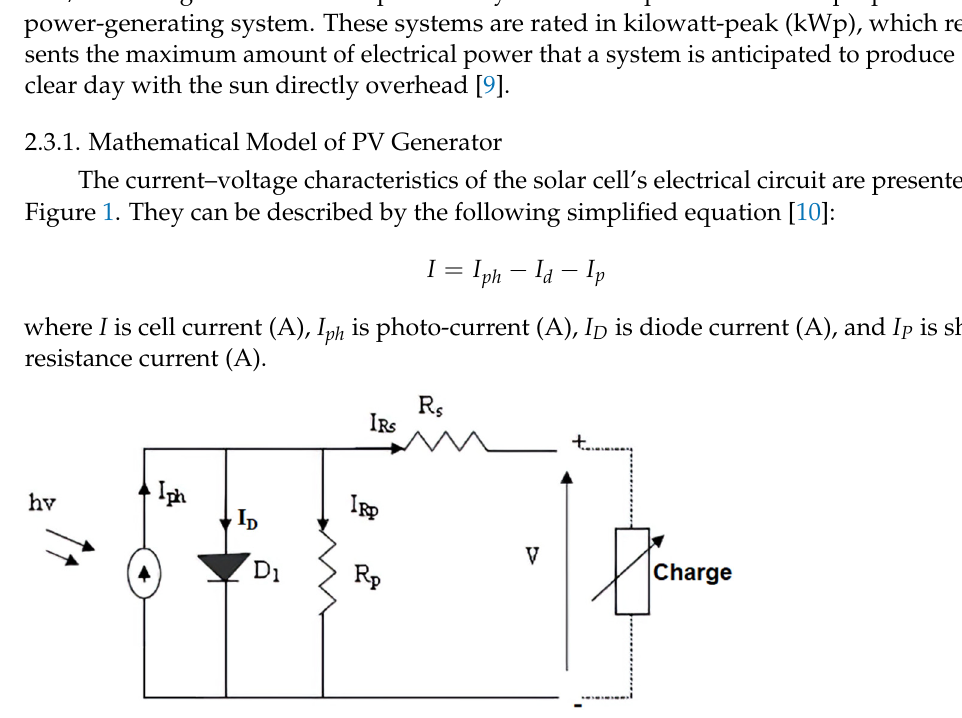
Figure 1. The equivalent electrical circuit of the PV module, showing the diode and ground leakage currents [11].